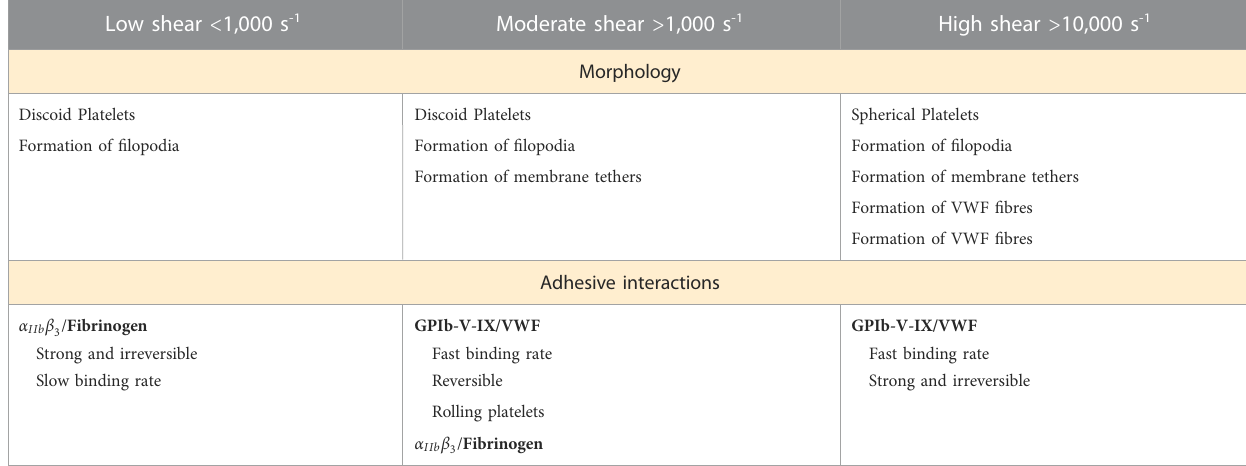
TABLE 1 Morphology and adhesive interactions associated to shear rate